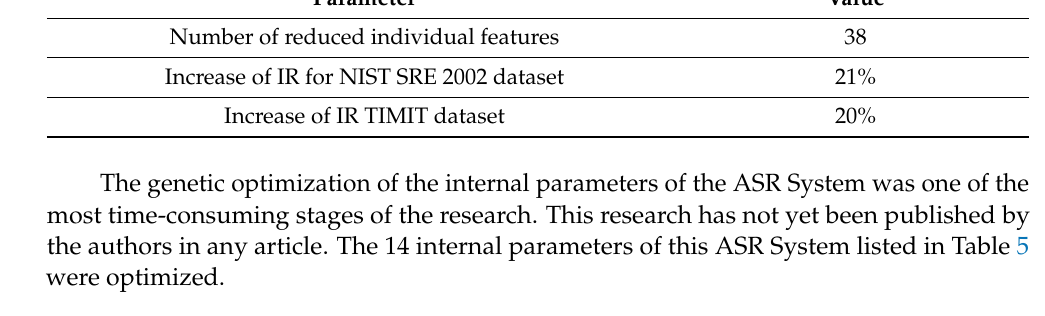
Table 5. A set of internal ASR System parameters subject to genetic